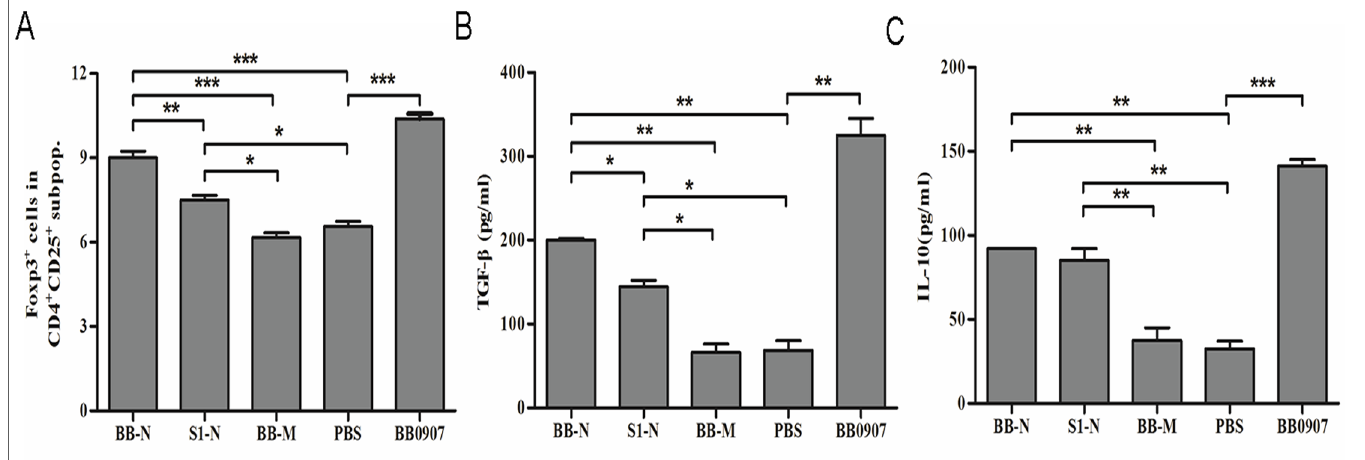
Fig 4. Effects of N protein of different virulent PRRSV strains on Tregs induction. (A) Percentage of Foxp3 + cells in the gated CD4 + CD25 + subpopulations of BB-N and S1-N. The BB-M was negative control. (B) Concentrations of TGF- β in supernatants of 3-day co-cultures. (C) Concentrations of IL-10 in supernatants of 3-day co-cultures. Data from three independent experiments. Data analysis was done using one-way ANOVA and significant differences are shown ( * P < 0.05, ** P < 0.01 and *** P < 0.001).